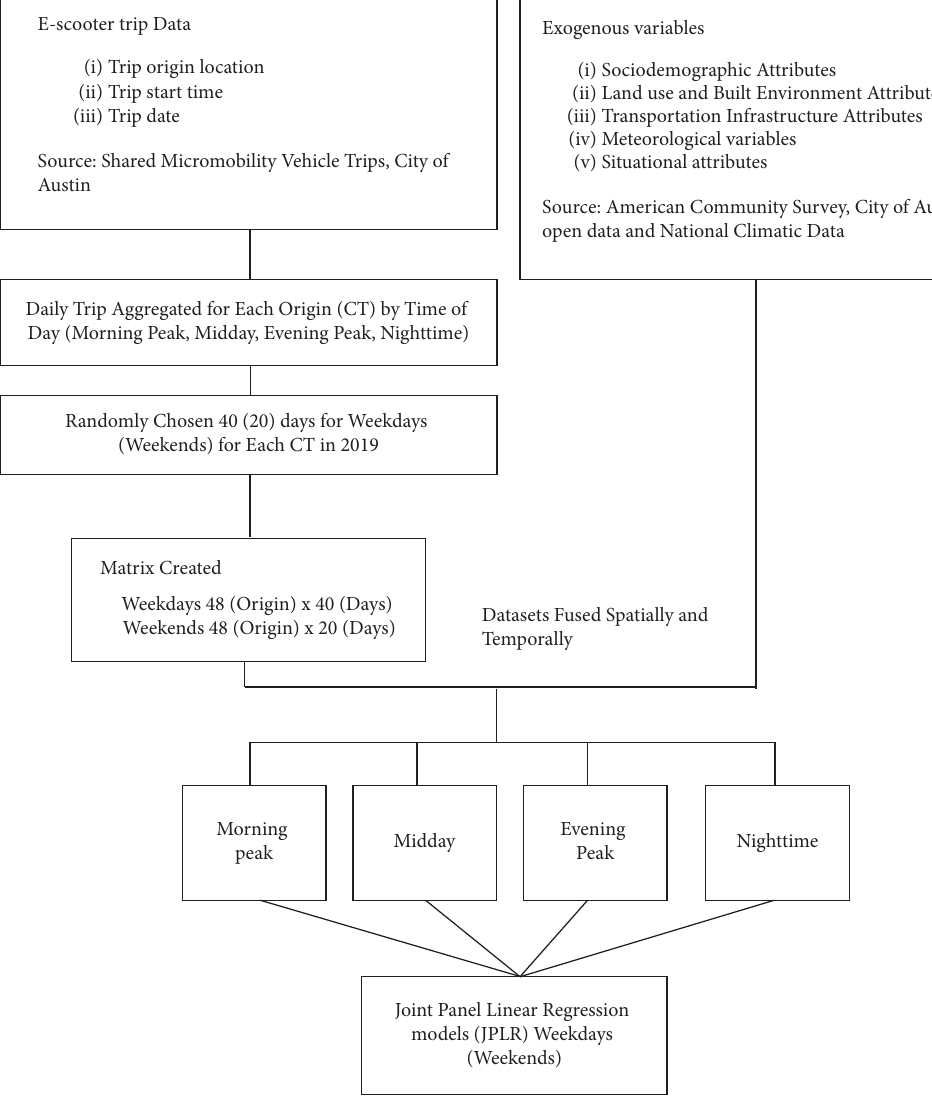
Figure 4: Flow chart demonstrating data preparation procedure for weekdays and